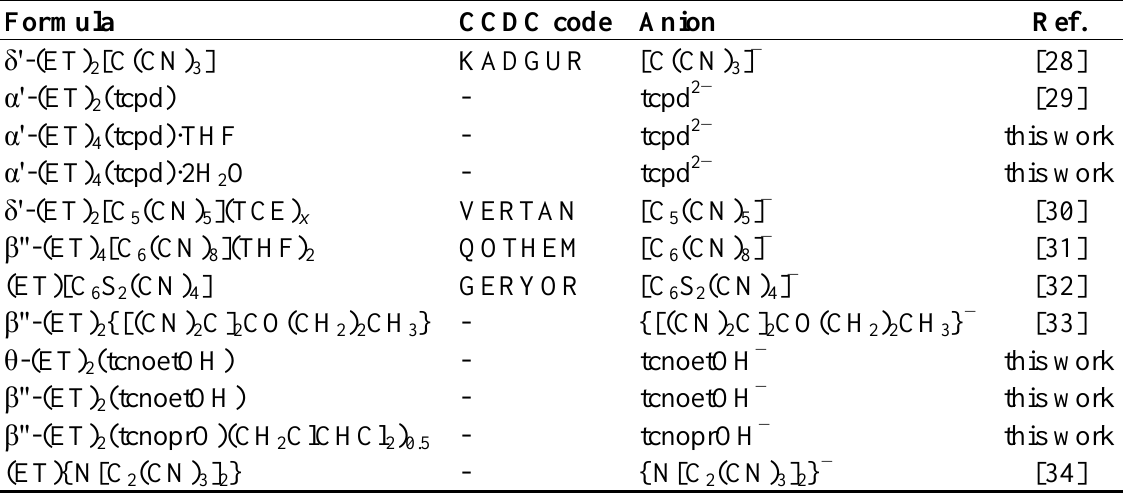
Table 2. ET salts with polycyano anions.